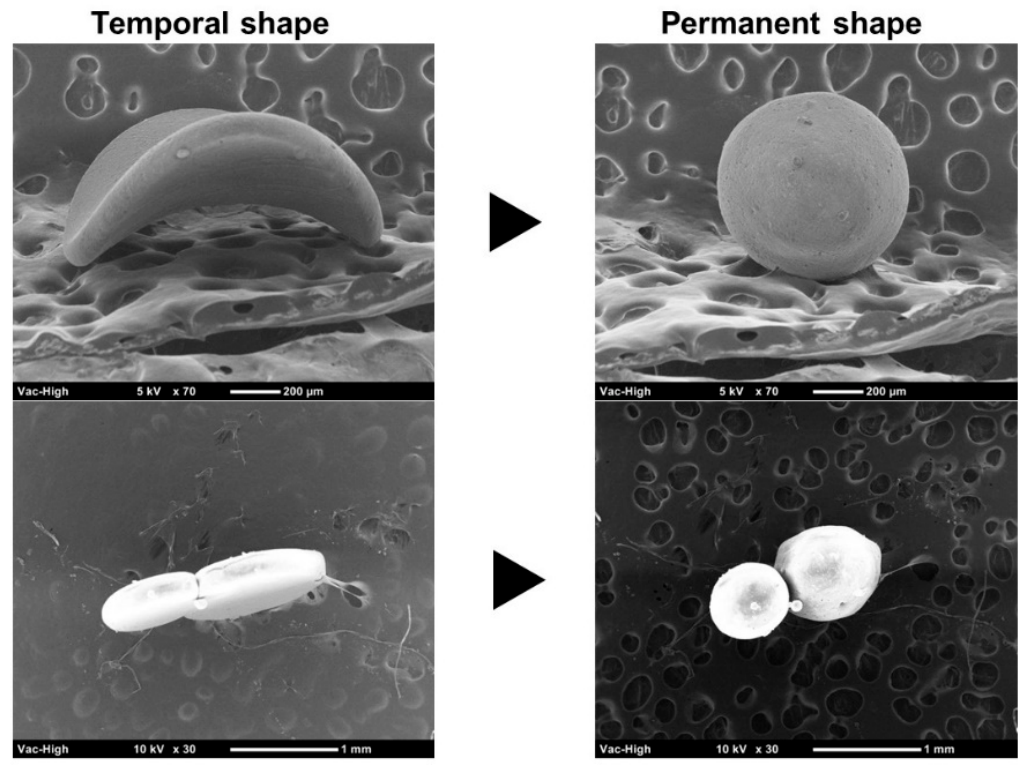
Figure 3. SEM images of thermally-induced shape recovery of shape-memory PCL microparticles with acceleration voltage of 5 kV ( top ) and 10 kV ( bottom ). Highly strained temporary shape ( left ) was returned to original permanent shape ( right ) by heating at 37 °C for 15 min. Images shows the shape recovery of particles for two different sets ( top and bottom ). Scale bars, 200 μ m ( top ) and 1 mm ( bottom ).